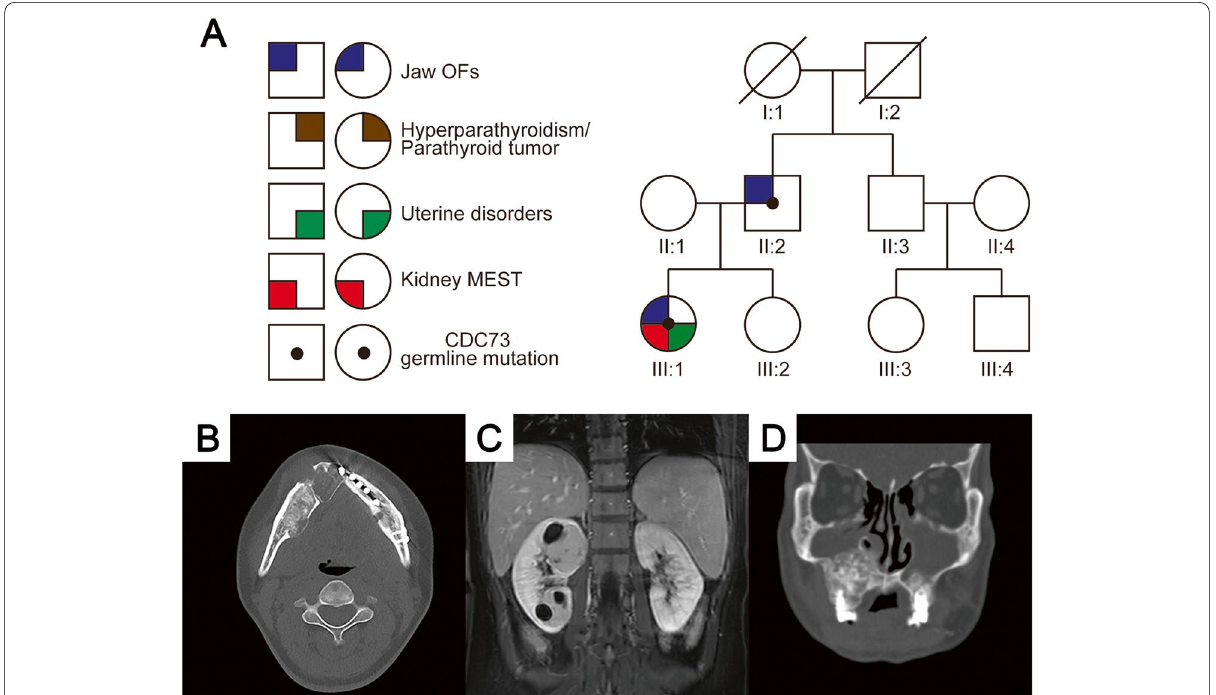
Fig. 1 Family pedigree and imaging. A Patients are designated by generation (Roman numerals I, II, III) and individual (Arabic numerals 1, 2, 3, 4). CDC73 germline mutation carriers are denoted with central black dots. Clinical manifestations related to CDC73 germline mutation are indicated in the quadrants as shown. B Axial CT of the patient III:1 showing multiple mixed-density lesions in the bilateral mandible, which are expansile and well demarcated. In the right mandible, central radiopacities are partly surrounded by a thin radiolucent rim. These lesions displaced teeth and the border of the mandible. A denovo lesion of the right mandible near the centerline showing low density. C Coronal MRI imaging of patient III:1 demonstrated two cystic/solid leisions in the right kidney showing mild enhancement during the delayed phase. D Coronal CT scan of the patient II:2 demonstrating bilateral maxillae lesions with mixed density. The right lesion is more obvious, invasion of the right maxillary